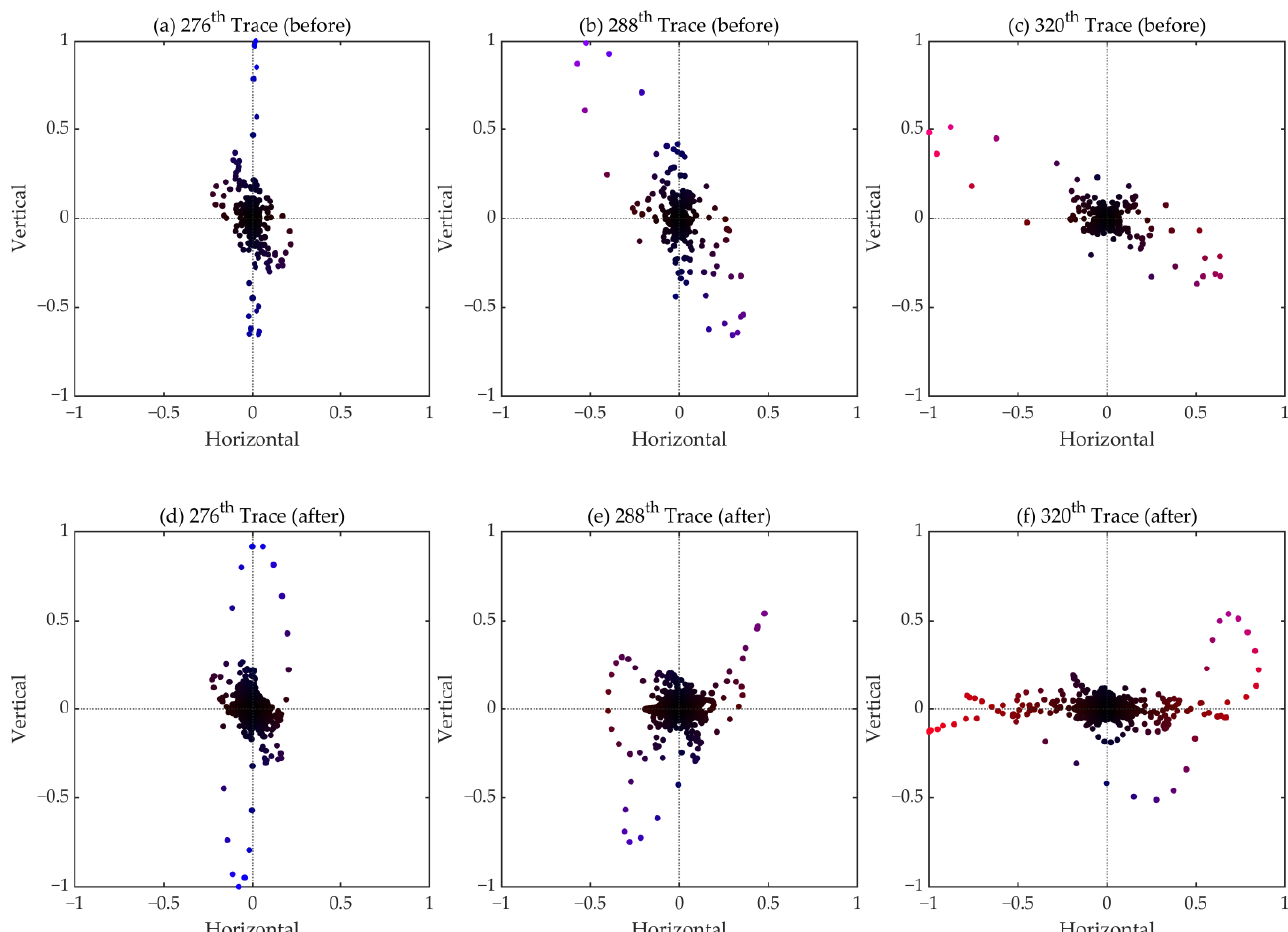
Figure 18. Polarization analysis of particle velocity before (the upper panel) and after (the lower panel) calibrations using data from ( a , d ) the 276th trace, ( b , e ) the 288th trace, and ( c , f ) the 320th trace. The horizontal velocity component determines the projection position of the data points on the x -axis. In contrast, the projection positions of the data points on the y -axis are determined by the vertical velocity component. Note that both axes have been normalized by the maximum value, so the labels between − 1 to 1 do not represent the absolute values of particle velocity data. The data points dominated by vertical polarization mode are painted bluer, and the data points dominated by horizontal polarization mode are painted redder.